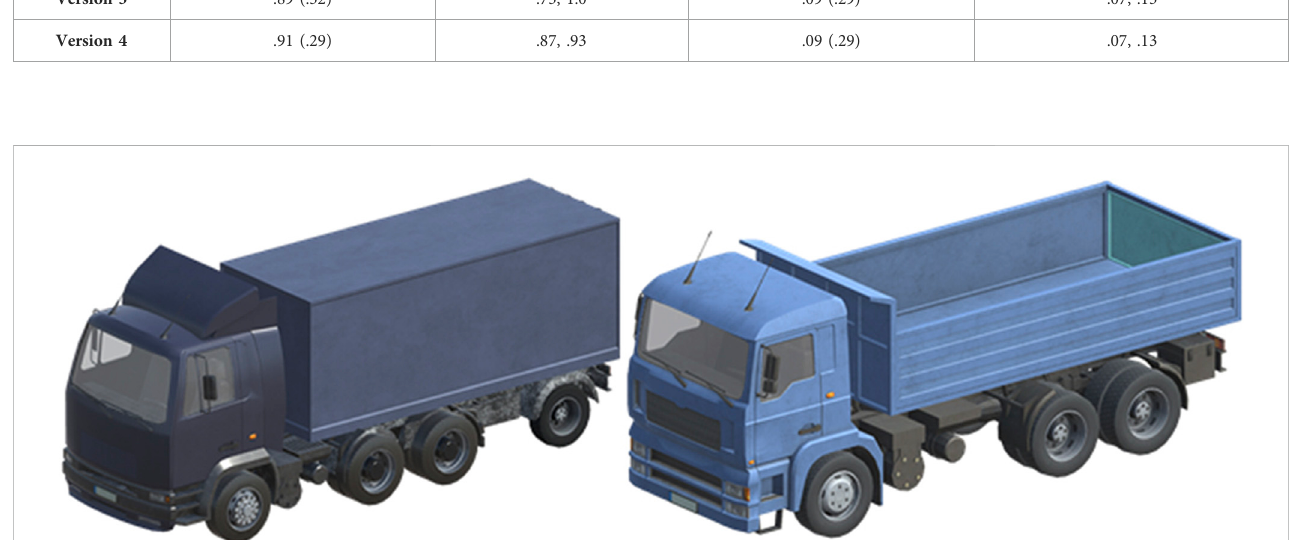
FIGURE 2 Example learned (old, left) and lure (new, right) stimuli developed for use in the